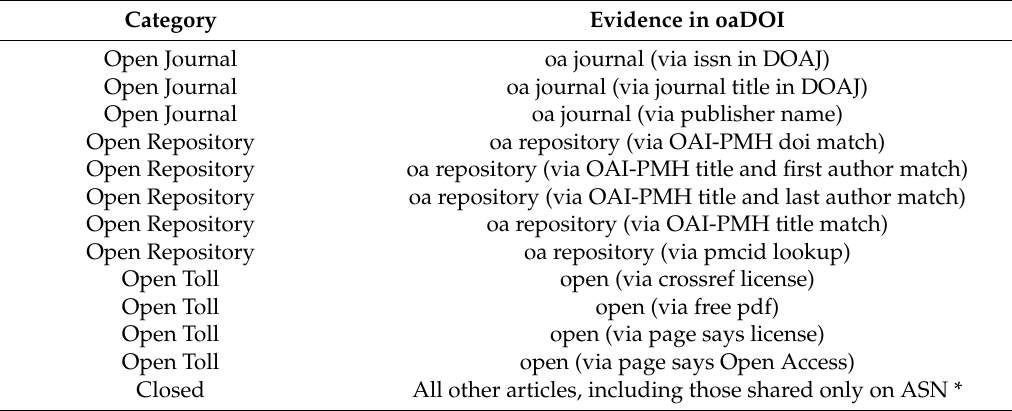
Table 2. oaDOI categories of open